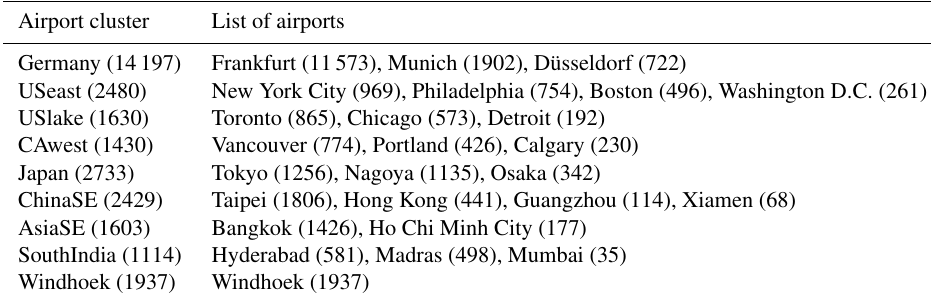
Figure 1. Geographical regions from the Global Fire Emissions Database (GFED) and airport clusters. Table 1. Description of airport clusters (the number of profiles is reported in